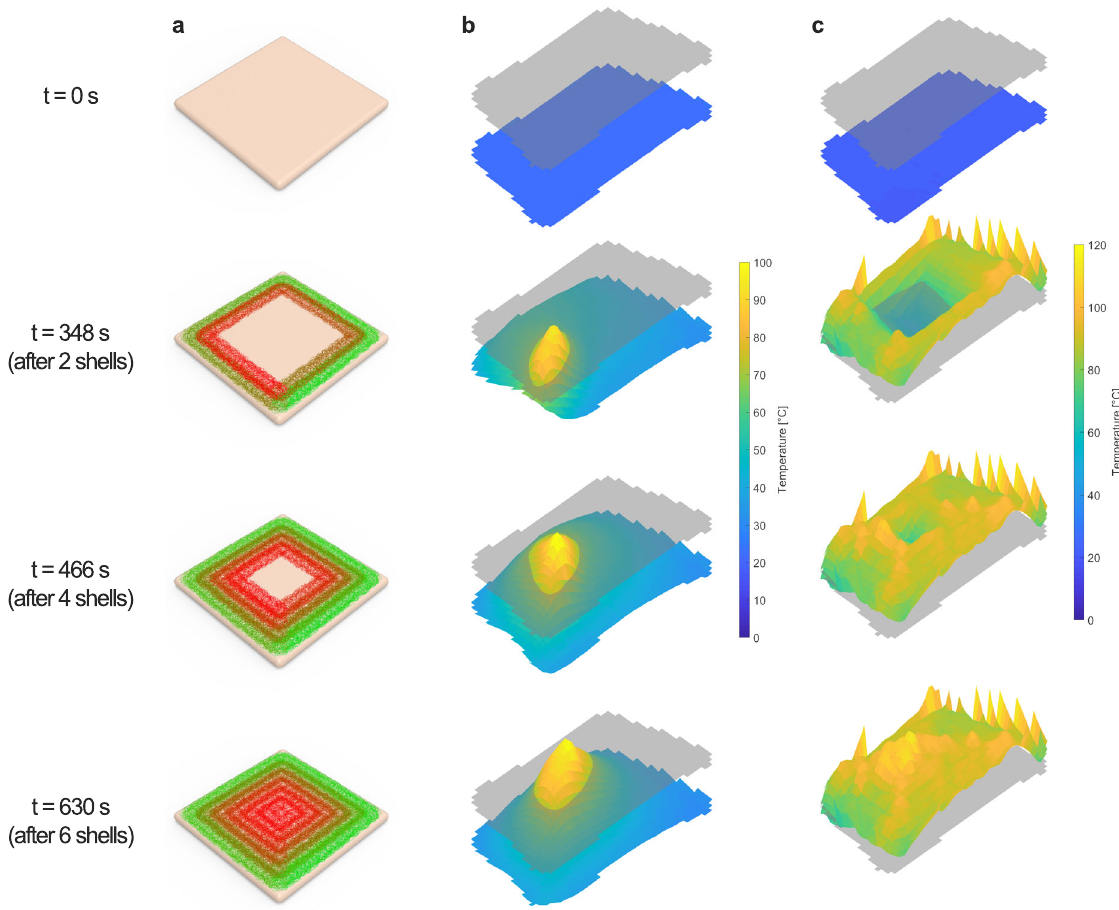
Fig. 4 Surface temperature during laser cooking at different time stamps, t(see Supplementary Video 2 for animations of these surface plots). a Visual rendering of chicken sample with superimposed spiral cooking pattern showing six shells of a repeated trochoidal pattern. Pattern transitions from green (starting position) to red (ending position) throughout the duration of the time stamp to the left of each tile. b Infrared camera readings from surface of chicken sample at a particular snapshot in time. c Aggregated maximum temperature recorded on the surface of the chicken sample up until the particular snapshot in time. The 2D gray transparent plane in ( b and c ) shows the minimum food safe temperature needed to eradicate Salmonella and E. coli (70 °C). An IR camera was used to capture surface temperature data for the laser-heated poultry